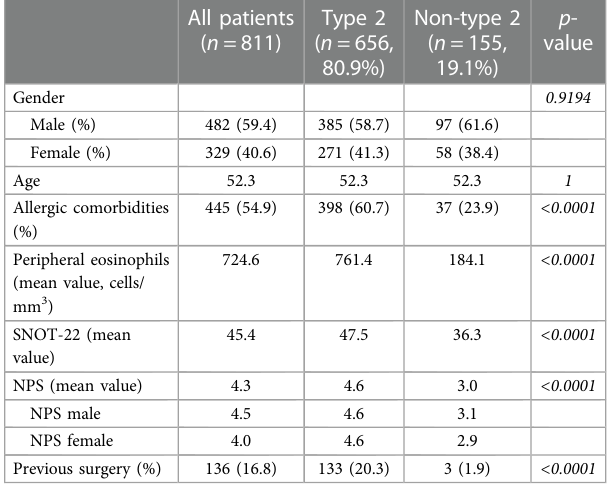
TABLE 2 Data from the Snif fi n ’ Sticks Identi fi cation Test divided in the two groups and showing differences between different percentage of smell impairment between males and